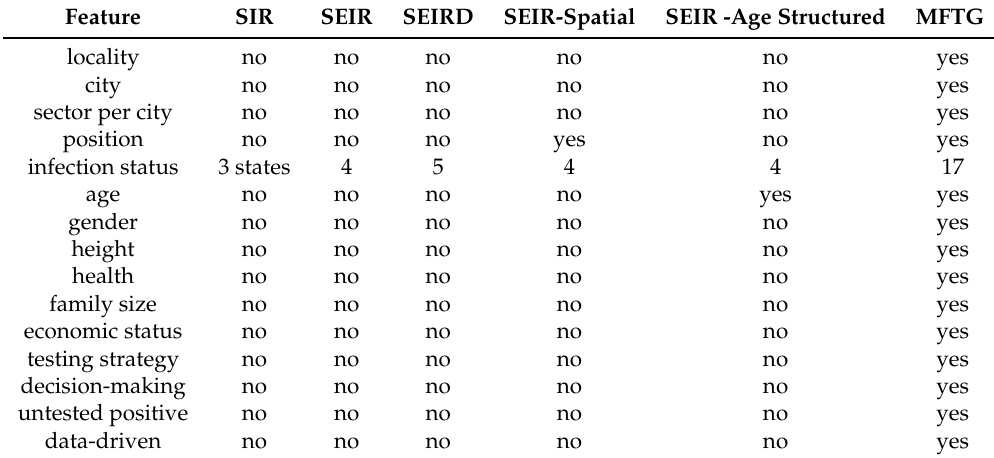
Table 1. Key features of the data-driven MFTG